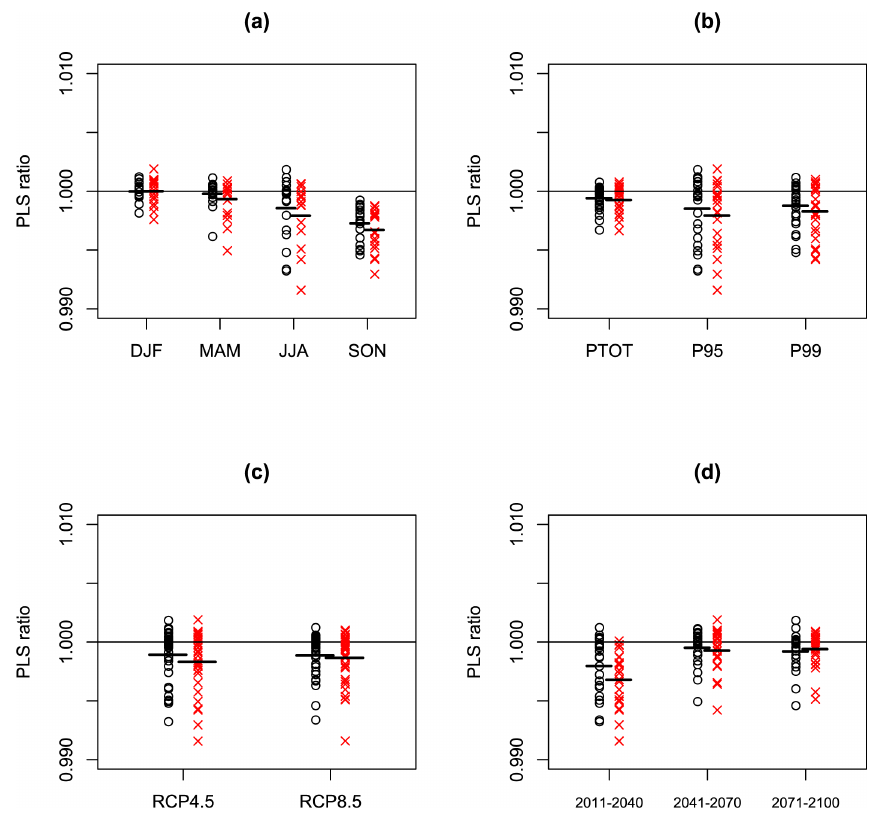
Figure 8. As Fig. 7 but now for 72 values of the PLS ratio derived from probabilistic forecasts from SPMA (black circles) and BPMA (red